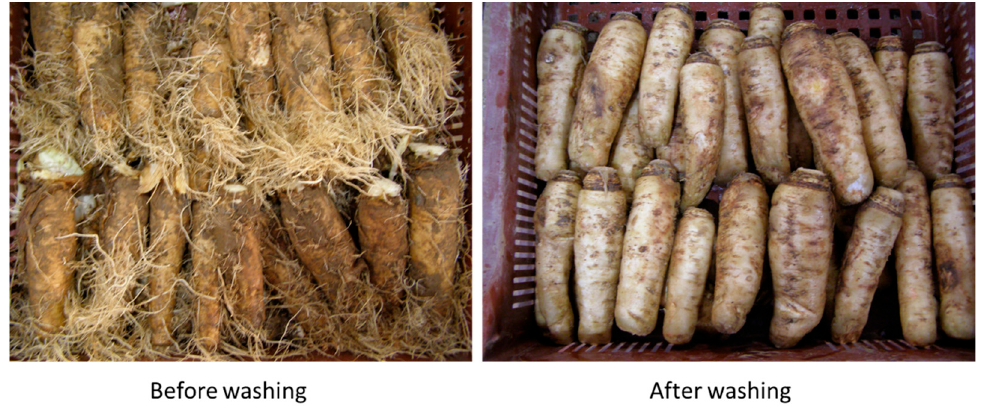
Figure 1. Forced witloof chicory roots before and after washing.